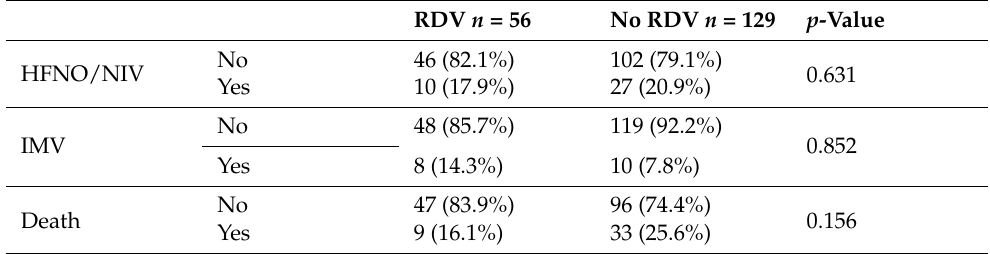
Table 4. Impact of remdesivir therapy on the course of COVID-19 in patients with SARD. RDV n = 56 No RDV n = 129 p